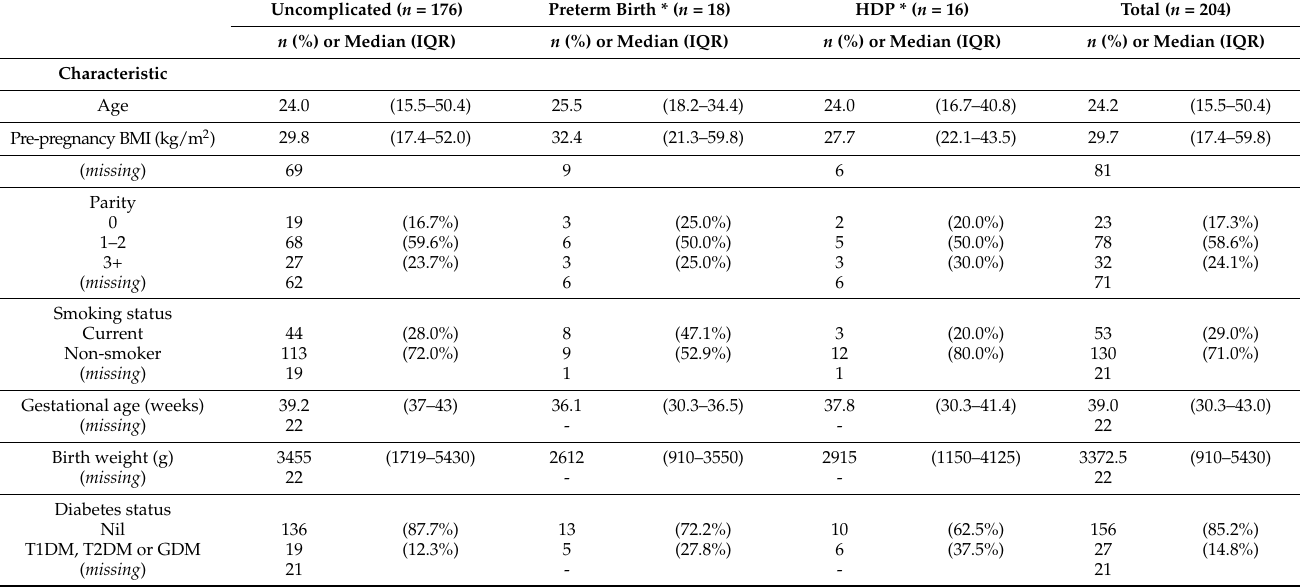
Table 2. Comparison of health characteristics and pregnancy outcomes of Indigenous pregnant women in the Gomeroi Gaaynggal cohort with or without a preterm birth or hypertension during pregnancy. Uncomplicated ( n = 176) Preterm Birth * ( n = 18)